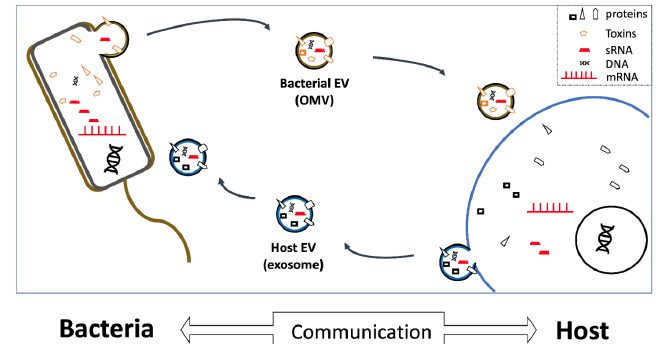
Figure 1. Vesicles as vehicles. Extracellular vesicles (EVs) secreted by both host and bacterial cells contain extracellular RNAs (exRNAs), as well as various other proteins and DNAs. EVs can be taken up by bacteria, or by host cells (in biofluids), and thereby likely critically mediate microbe-host communication by releasing small exRNAs capable of regulating recipient-cell gene expression. OMV, outer-membrane vesicle; sRNA, small RNA; mRNA, messenger